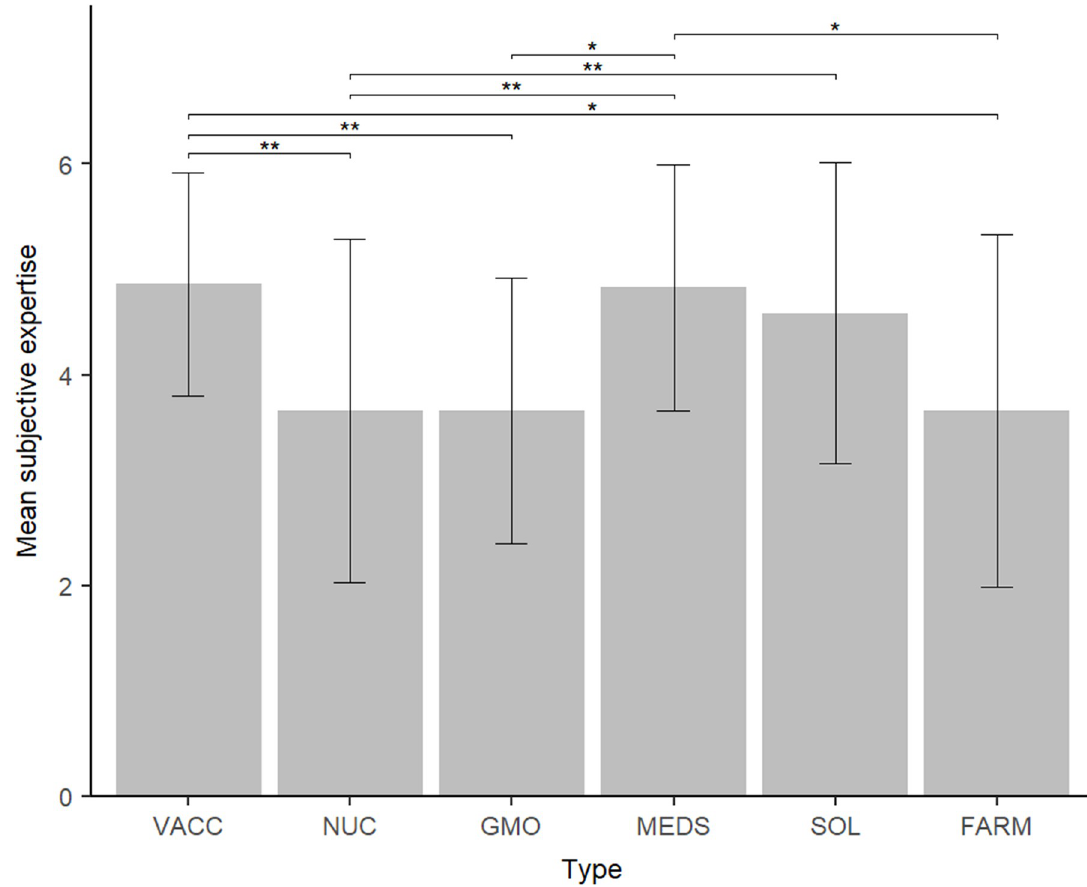
Fig 6. Rating of self-perceived expertise for six domains presented during the study. VACC = vaccination, NUC = nuclear energy, GMO = GMO technology, MEDS = medicines, SOL = solar energy, FARM = natural farming. Error bars represent standard deviation. P < .01, � p <